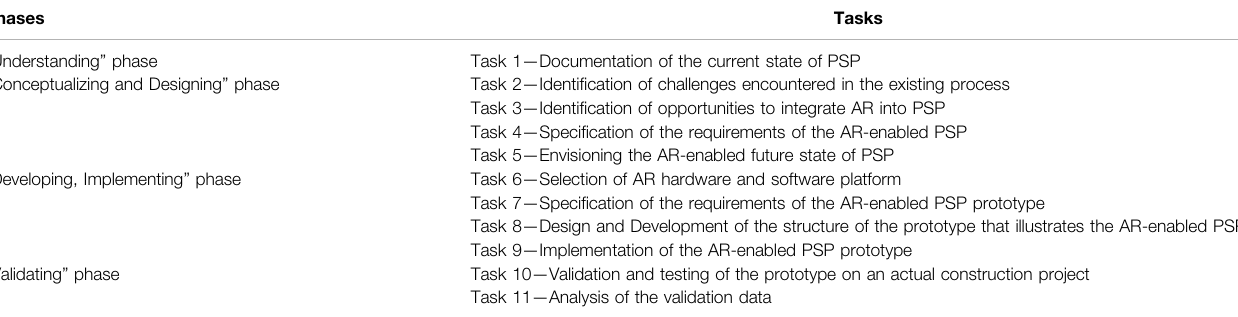
TABLE 1 | Tasks compromising the four-phase research plan. Phases Tasks “ Understanding ”